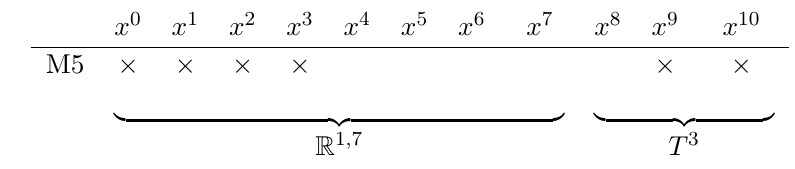
↔ S 1 is identical to the original 9 8